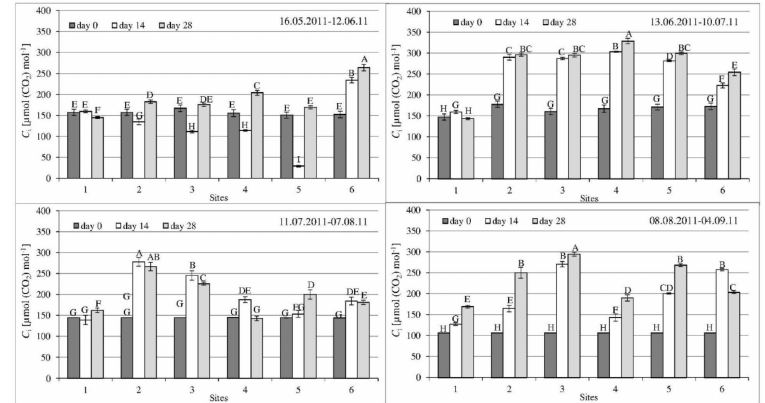
Figure 4. Intercellular CO 2 concentration ( C i ) of L. multiflorum measured at control and exposure sites during four series. Vertical bars represent standard errors; di ff erent letters denote significance di ff erence at level α ≤ 0.05 between all treatments within each